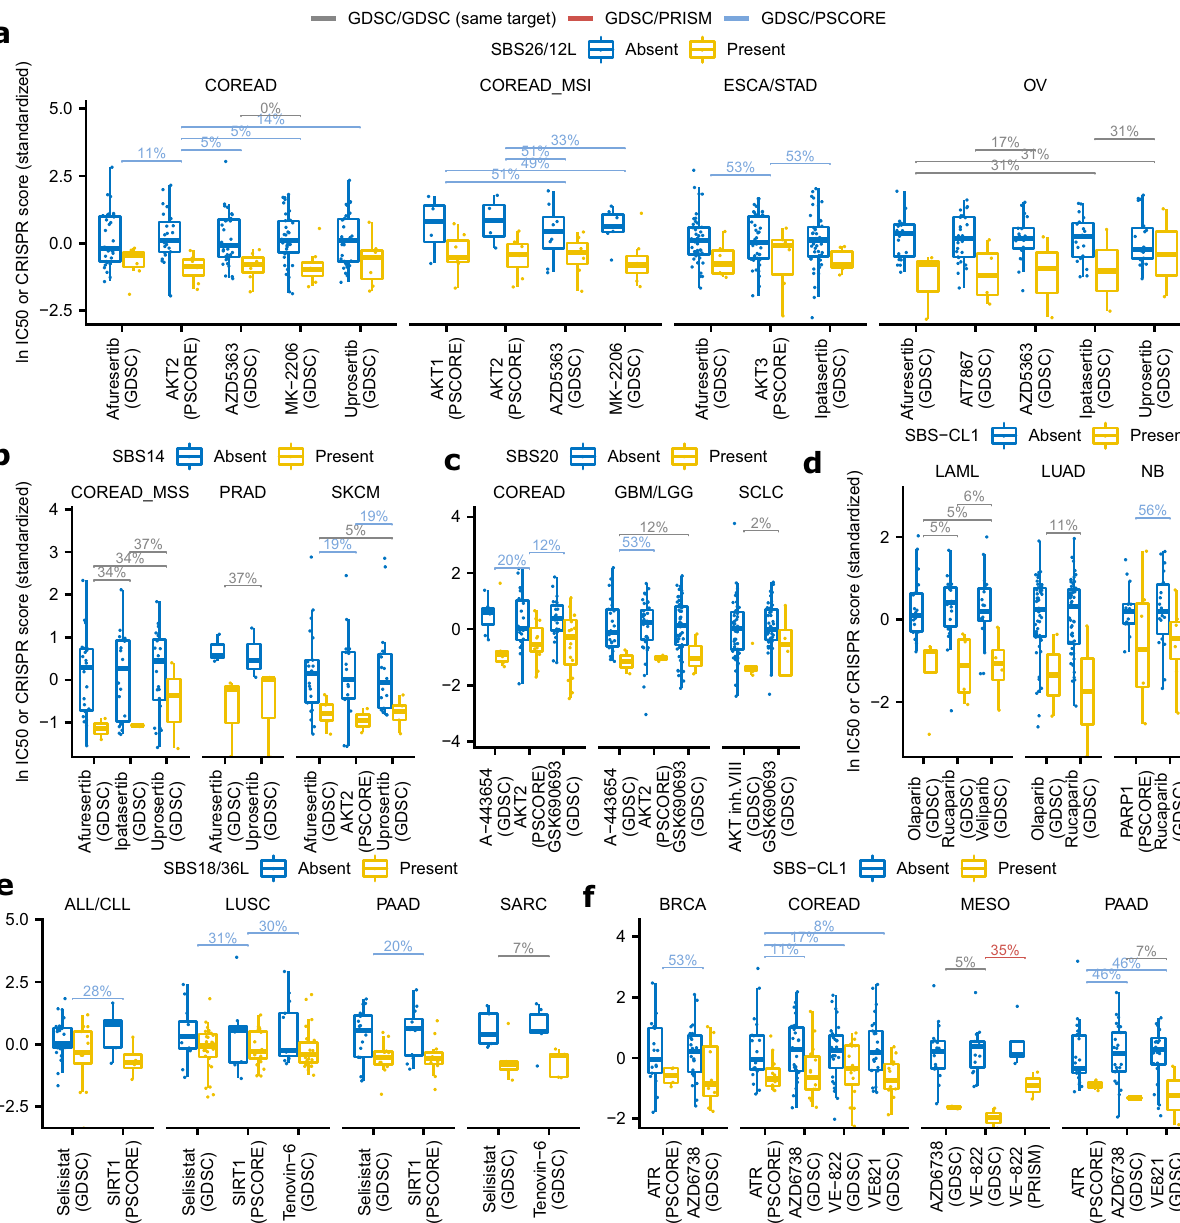
Fig. 6 Associations with drug sensitivity or resistance that replicate in independent datasets. a – f Examples of associations of mutational signatures with drug sensitivity that replicated (using tests in Fig. 3a) multiple times, across different cancer types and/or different types of replication tests. Y-axes show a Z-score derived from either the ln IC50 value (drug sensitivity: “ GDSC ” or “ PRISM ” columns) or from the CRISPR essentiality score ( “ PSCORE ” columns). Horizontal brackets show FDR for replicated associations with the presence/absence of a given mutational signature, obtained via a randomization test (Fig. 3a), where color denotes the type of the test (see legend at top of plot). The center lines of box plots denote medians and the box hinges correspond to the 1st and 3rd quartiles, while whiskers extend to 1.5 × IQR from the hinges. Source data are provided as a Source Data fi